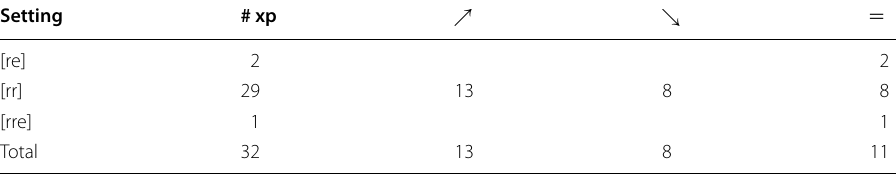
Table 4 Impact of the setting on the coverage of the synthesised BNs Setting #